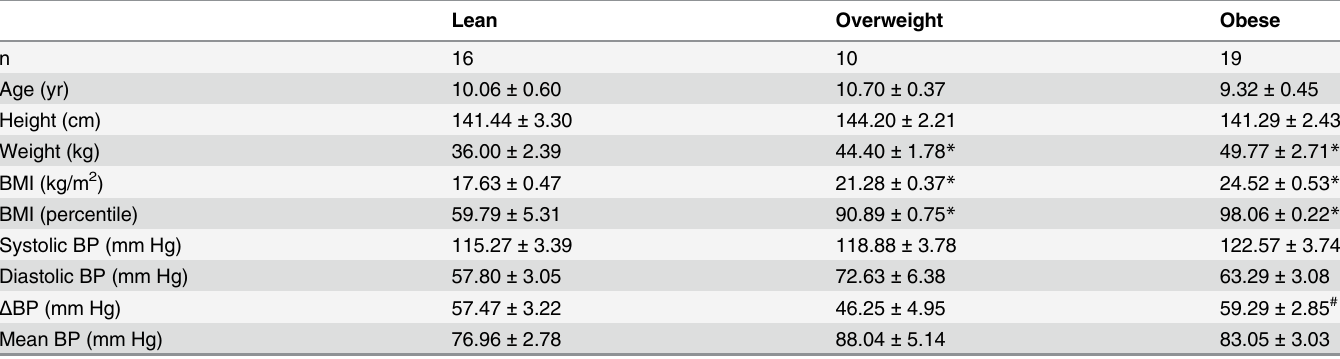
Values are given as the mean ± SEM. Abbreviations: BMI, body mass index; BP, blood pressure; Δ BP, Systolic BP-Diastolic